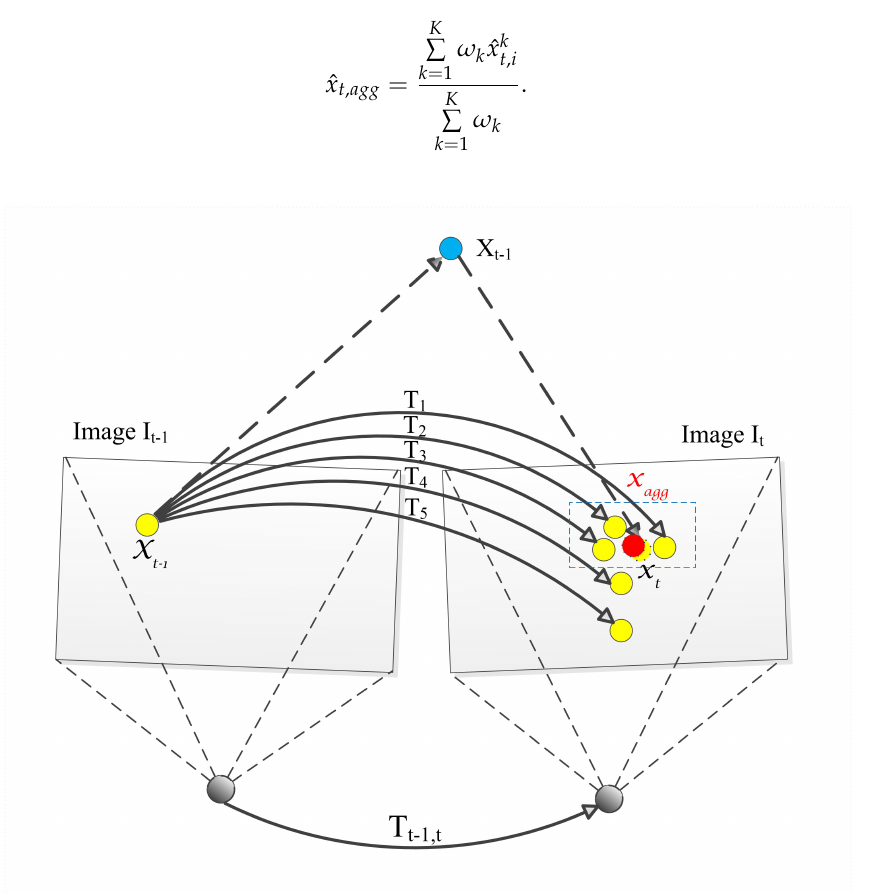
Figure 6. Hypothesis aggregation. Three best hypotheses in the blue dashed rectangle are aggregated, thus the aggregated point x agg is closer to the real matching point x t